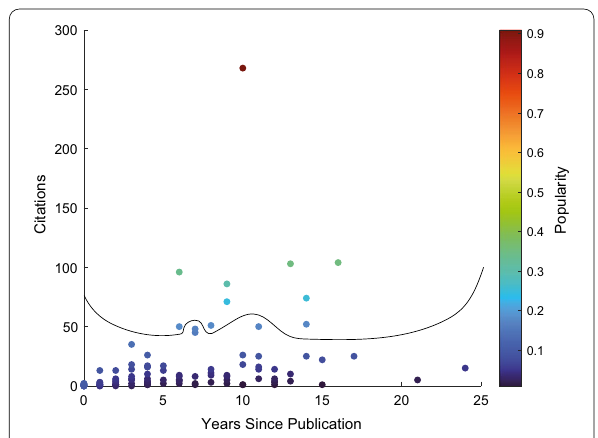
Fig. 10 Popularity electroencephalography publications in relation to citations and years since publications, with the threshold line for the top 10